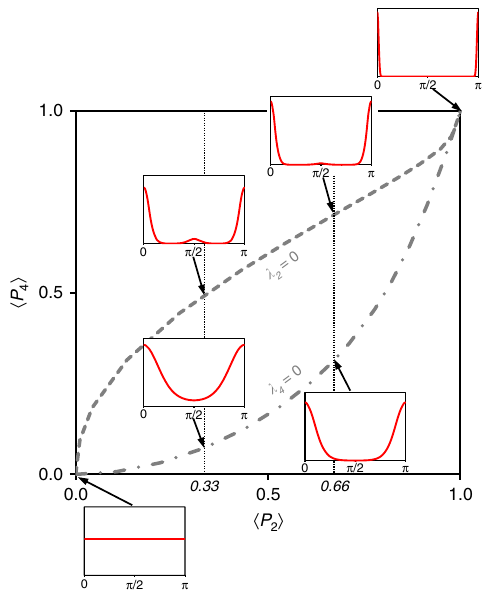
Fig. 3 The 〈 P 4 〉 − 〈 P 2 〉 order parameters interrelations based on maximum- entropy theory. According to MEM theory, each pair ( λ 2 , λ 4 ) de fi nes a full set of 〈 P l 〉 momenta and thus a given shape of the ODF. Here, selected representative ODFs (calculated from Eq. (18)) are shown in inserts as red lines in the case of λ 2 = 0 or λ 4 = 0 for 〈 P 2 〉 values of 0.00, 0.33, 0.66, and